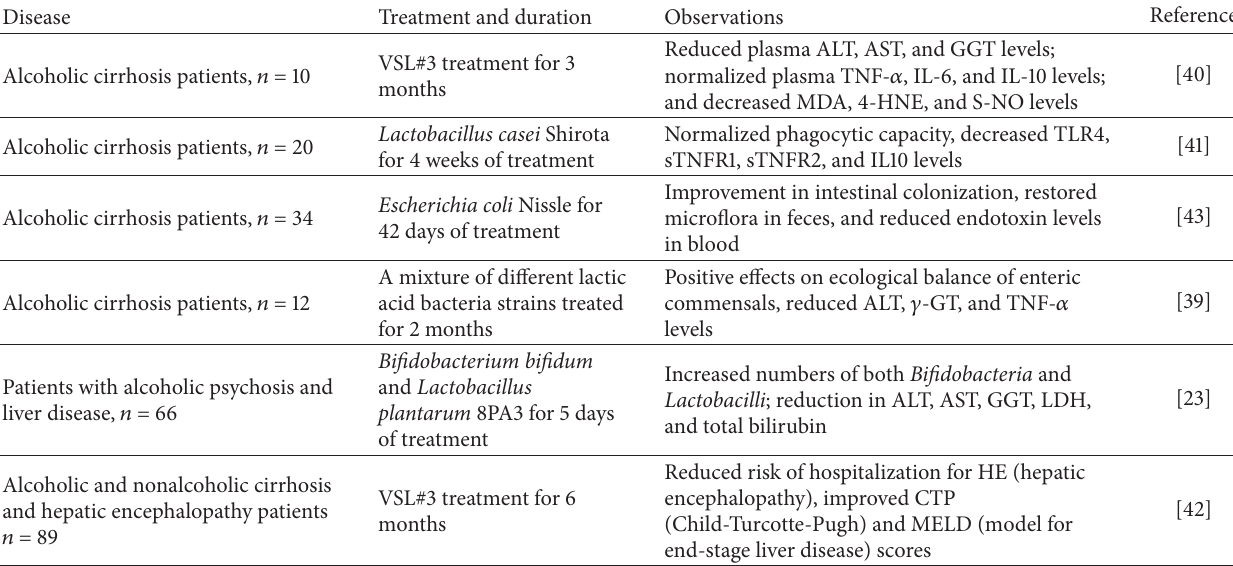
Table 2: Probiotics in ALD—clinical